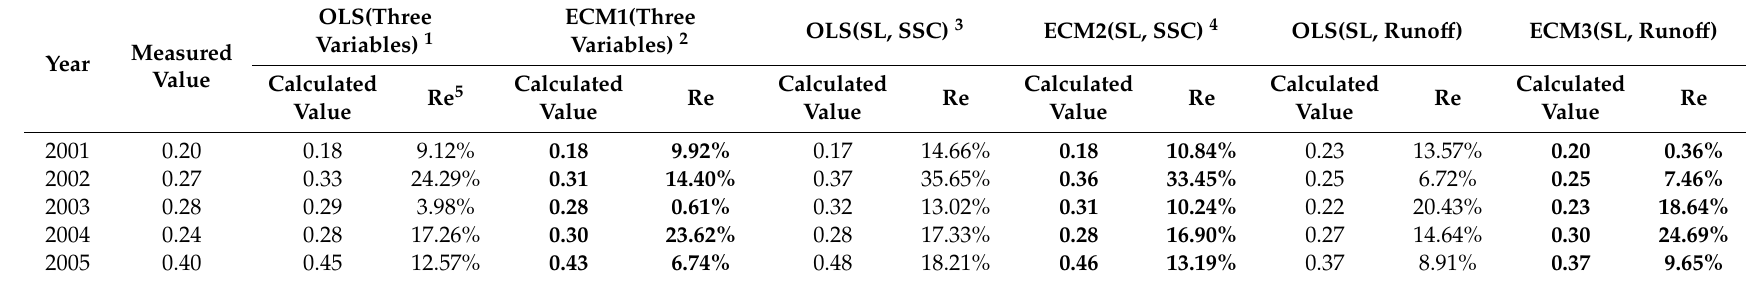
Table 4. Predicted results of sediment transport at Toudaoguai station.